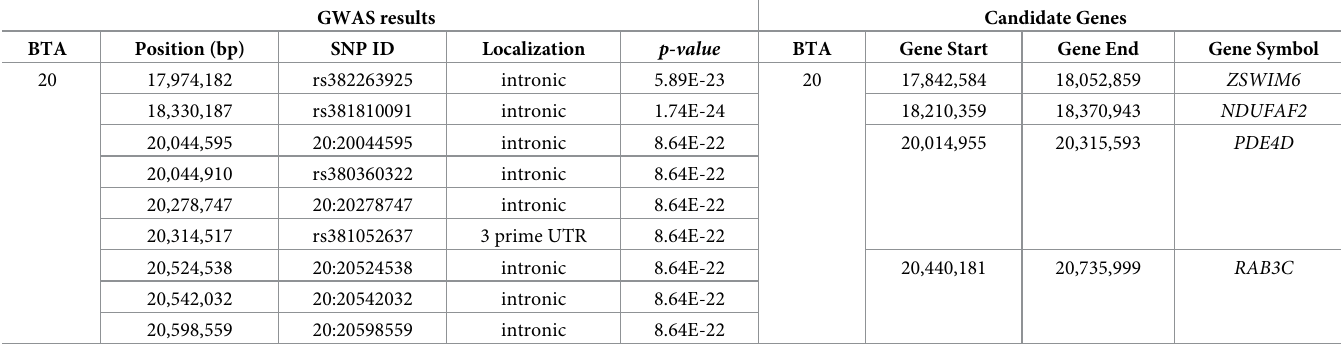
Table 2. Genomic localization of the most significant SNPs on